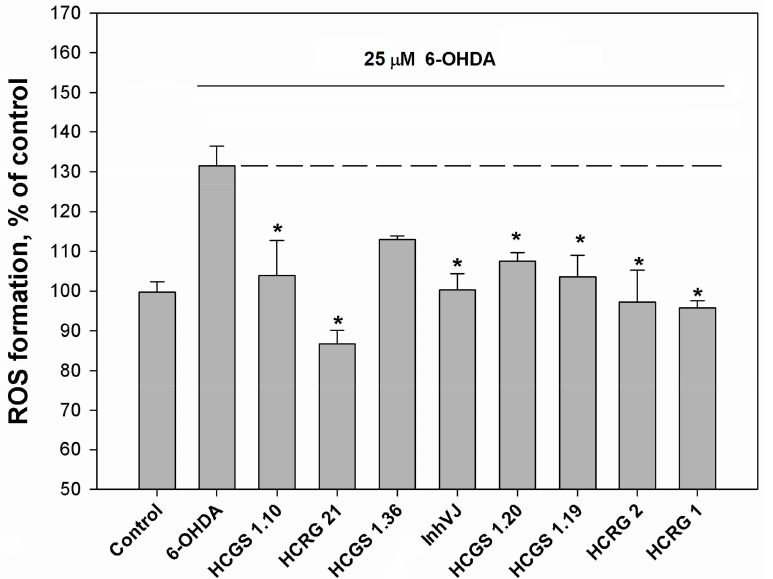
Figure 5. Effects of Kunitz-type peptides on ROS formation in Neuro-2a cells induced by 6-OHDA. Differences between 6-OHDA-treated cells alone (designated by the dotted line) and with peptides pre-incubated during 1 h are significant with * p < 0.05. Data were obtained in three independent replicates and calculated values were expressed as mean ±